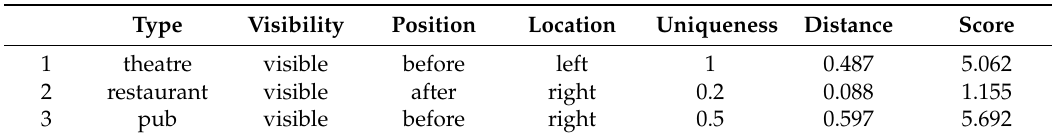
Figure 3. Location of features. Squares represent points on the feature closest to the reference point, and circles represent points on the feature that are closest to the waypoint. A square filled with a circle signifies the two points are at the same (or very close) locations (source data © OpenStreetMap contributors). Table 2. Landmark candidates for a decision point.